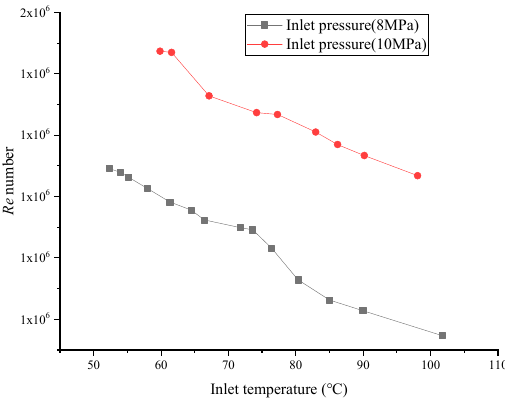
Figure 14. The local Re number of outlet flow under different inlet conditions in Fan’s experiment.